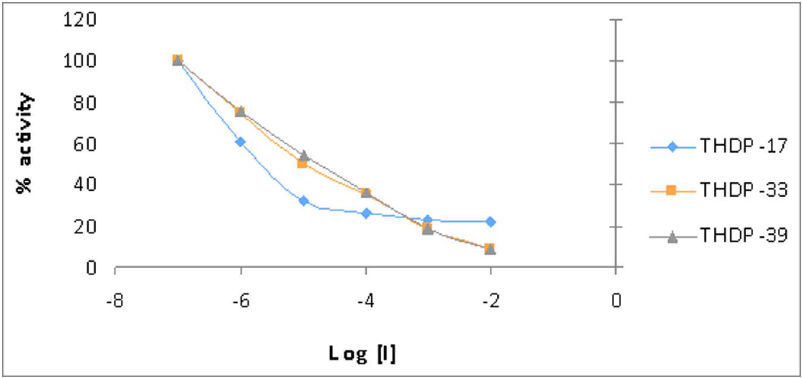
Figure 1. Inhibitory effect on glutaminase activity of several compounds tested in this study. Data are shown in log scale (inhibitor concentration), being 100% activity measured without inhibitor. There was not significant differences among compounds tested (Student t test; p . 0.05). THDP-17 was chosen on toxic effect base.